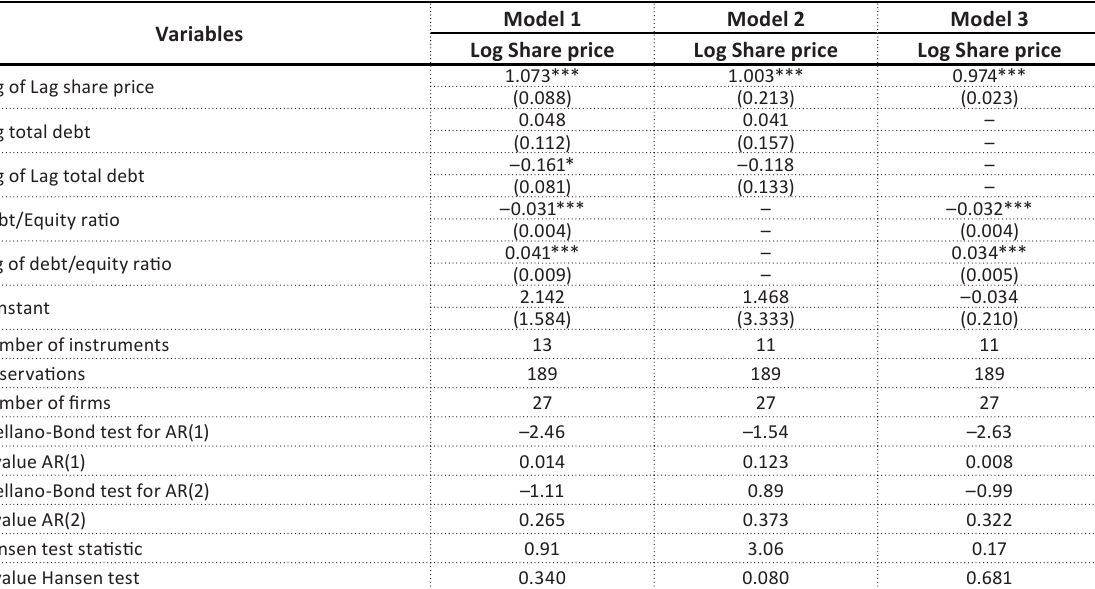
Table 3. Full sample regression results